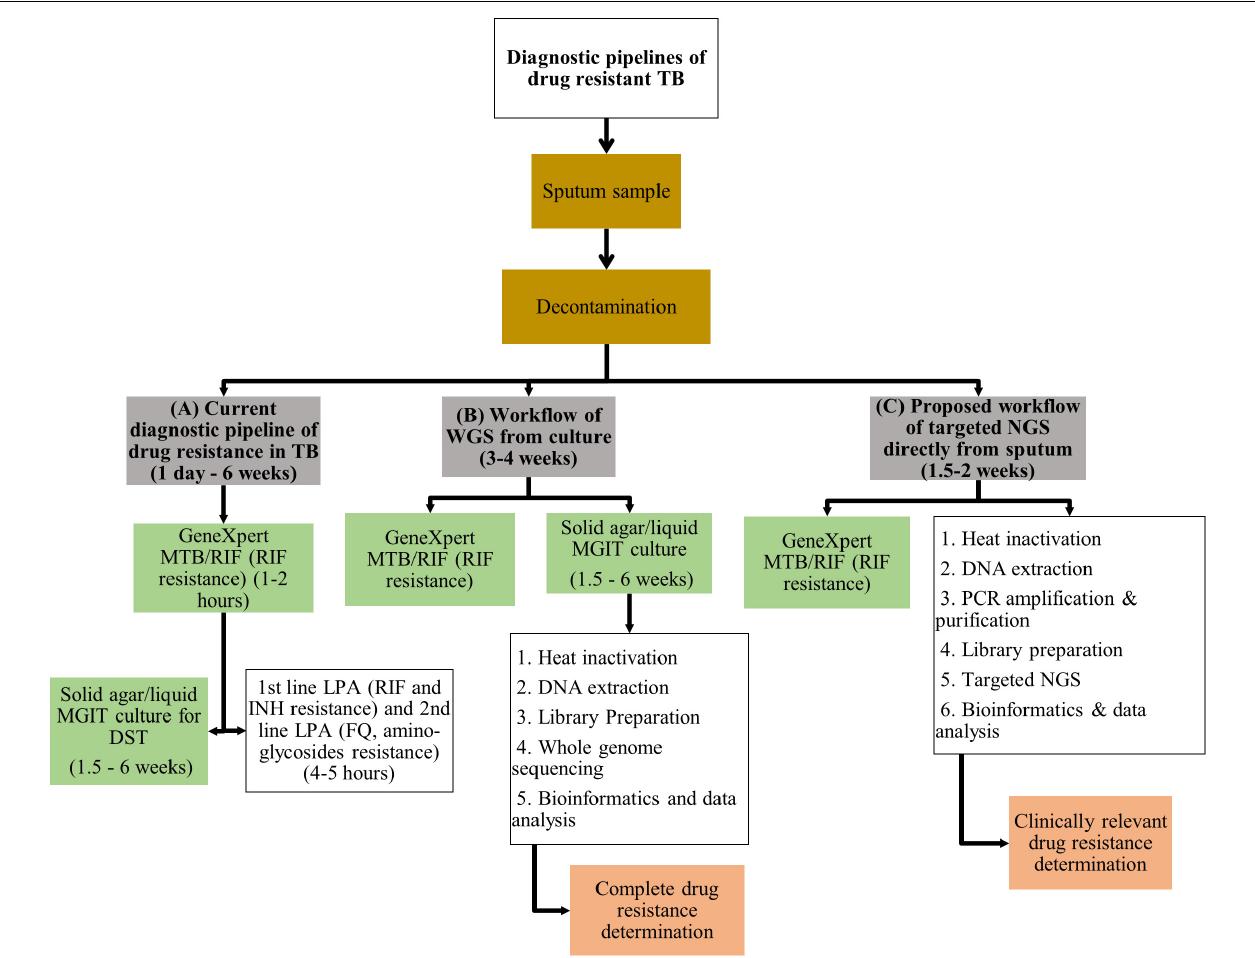
FIGURE 1 | Illustration of (A) the current diagnostic pipeline of drug resistance in TB, (B) workflow of WGS from culture, and (C) proposed workflow of targeted NGS directly from sputum. TB, tuberculosis; WGS, whole genome sequencing; MTB, Mycobacterium tuberculosis ; MGIT, mycobacterial growth indicator tube; DST, drug susceptibility testing; LPA, line probe assay; RIF, rifampicin; INH, isoniazid; FQ, fluoroquinolones; DNA, deoxyribonucleic acid; NGS, next generation sequencing; PCR, polymerase chain